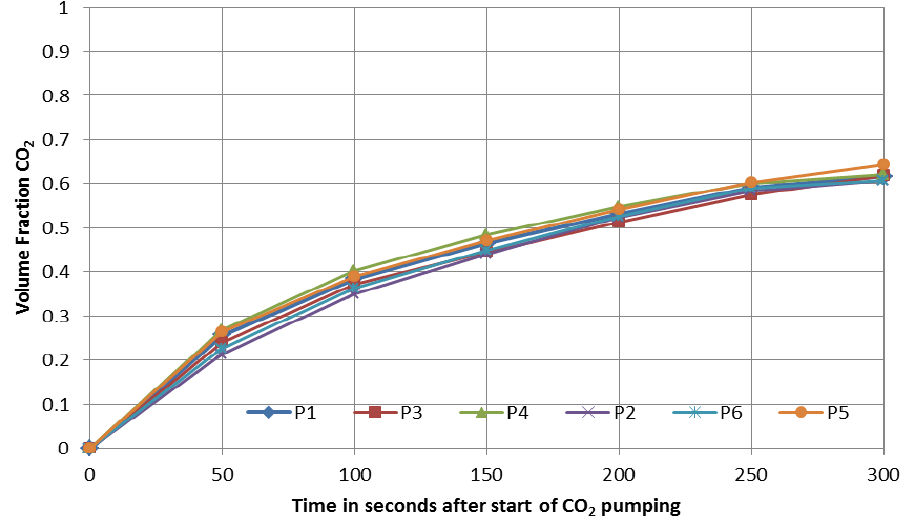
Figure 2. Computational fluid dynamics (CFD) results for the above test conditions at the 25 cm height horizontal cut plane at the sample tube locations shown in Section 3.2.